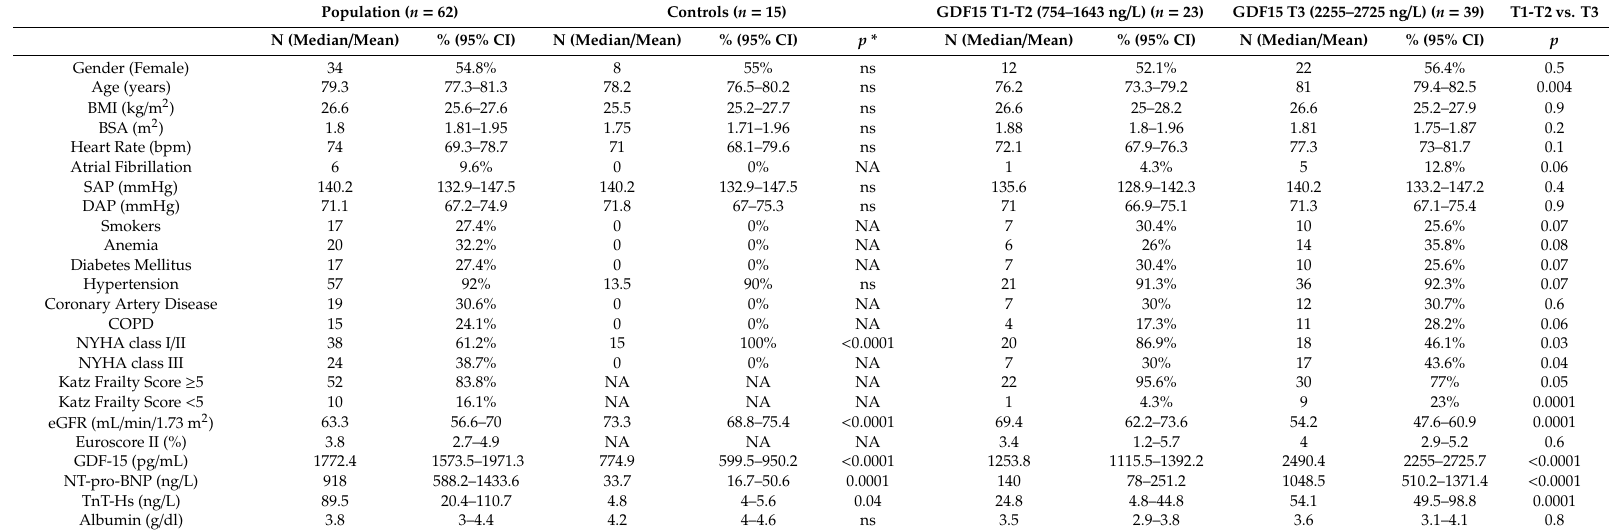
Table 1. Demographic and biohumoral characteristics of the study population (whole population and according to GDF15 tertiles, T) and